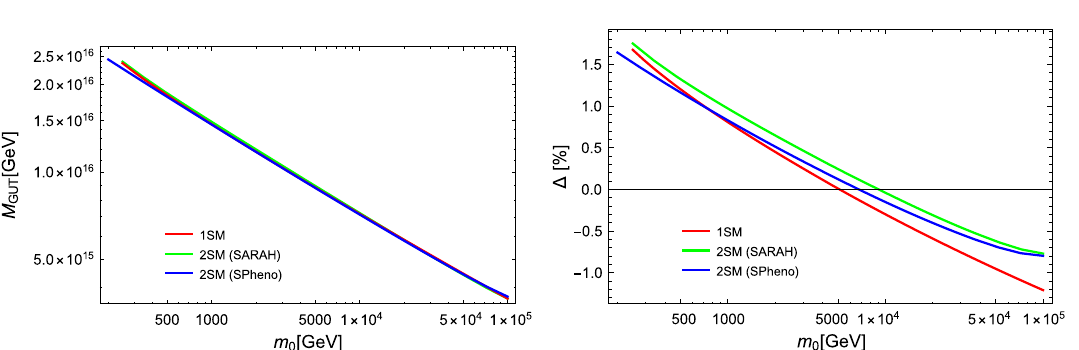
Fig. 3 The same as Fig. 2 for the gauge couplings g 1 , g 2 and g 3